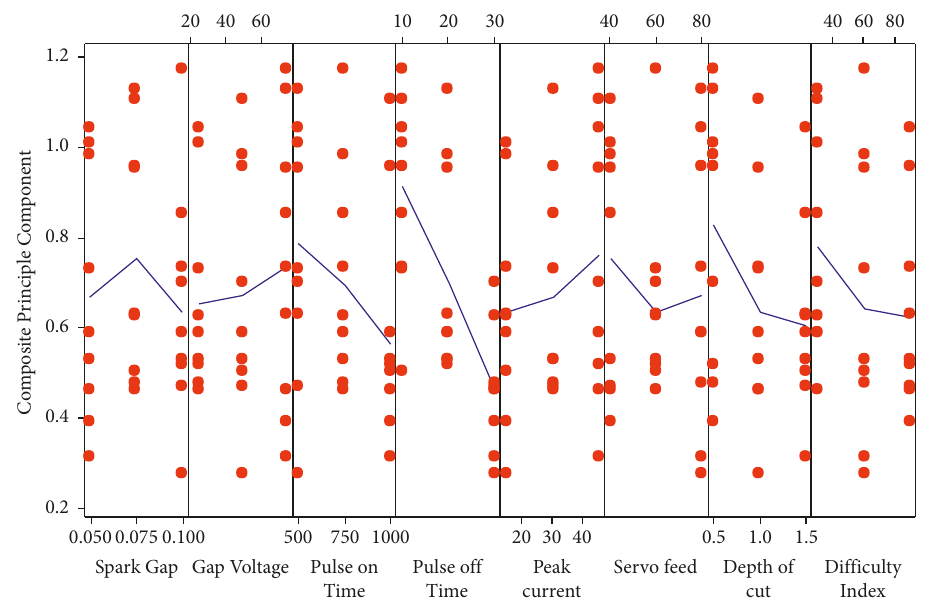
Figure 8: Matrix plot for the composite principal